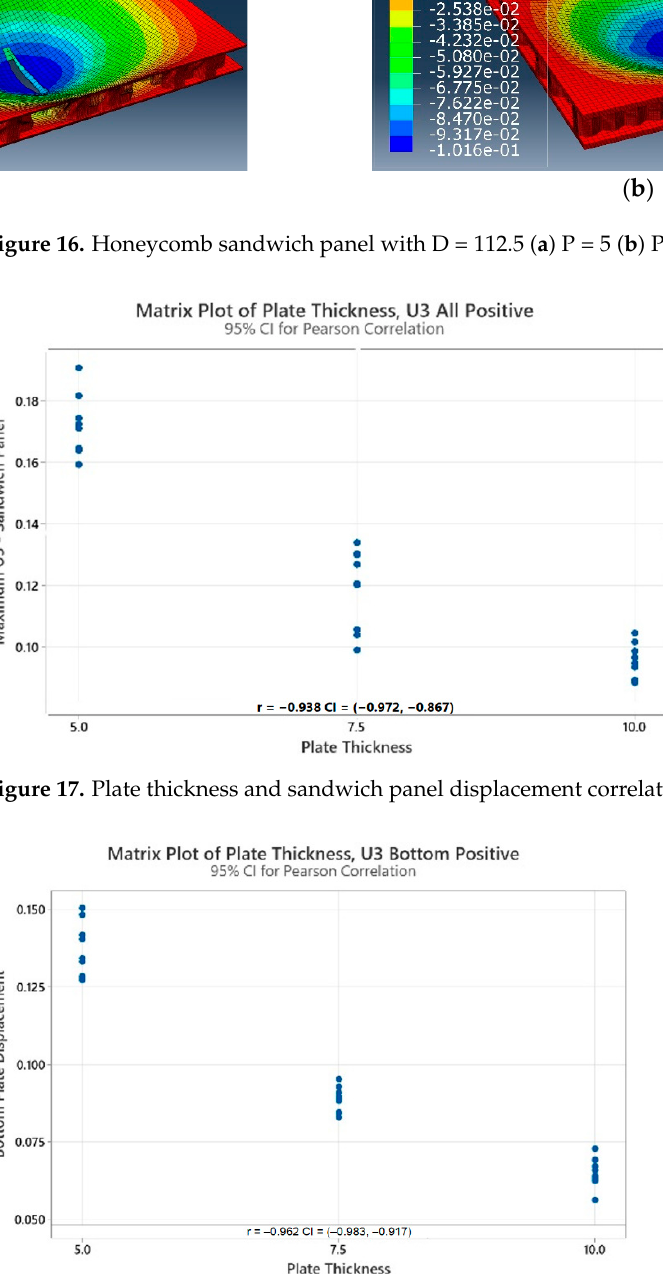
Figure 19. Damage development for mushroom shape with different façade plate thickness: 5 mm, 7.5 mm, and 10 mm with core–core spacing of 112.5 mm.